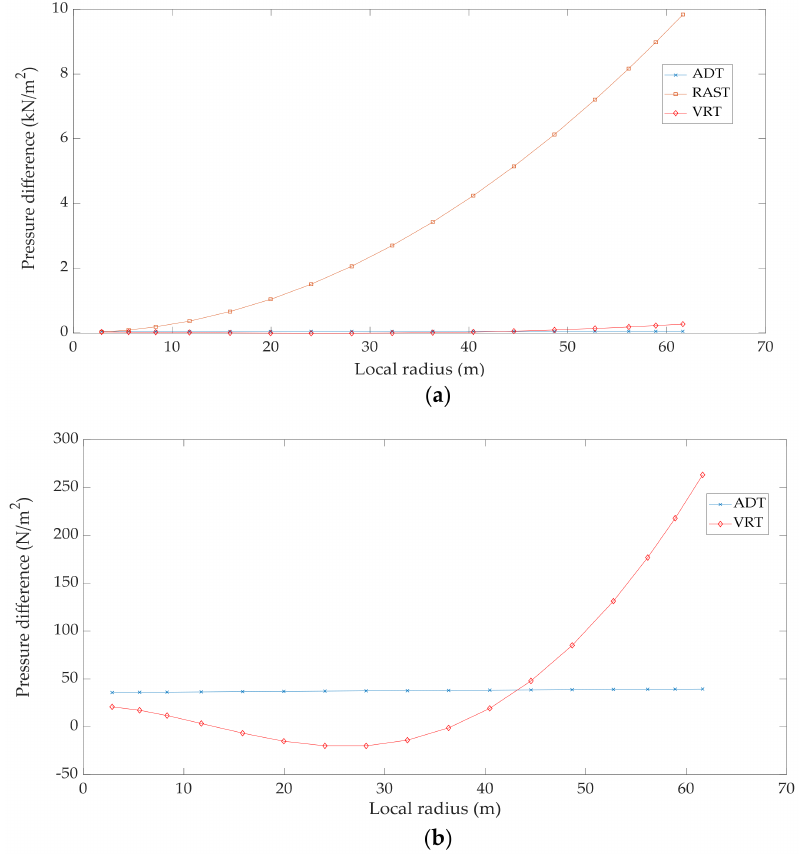
Figure 6. Pressure difference as a function of the local radius: ( a ) plots of the ADT, the RAST and the VRT; and ( b ) those of the ADT and the